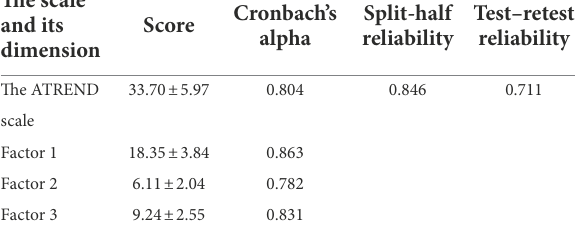
TABLE 3 Reliability analysis for the Chinese version of the ATREND scale. The scale and its dimension